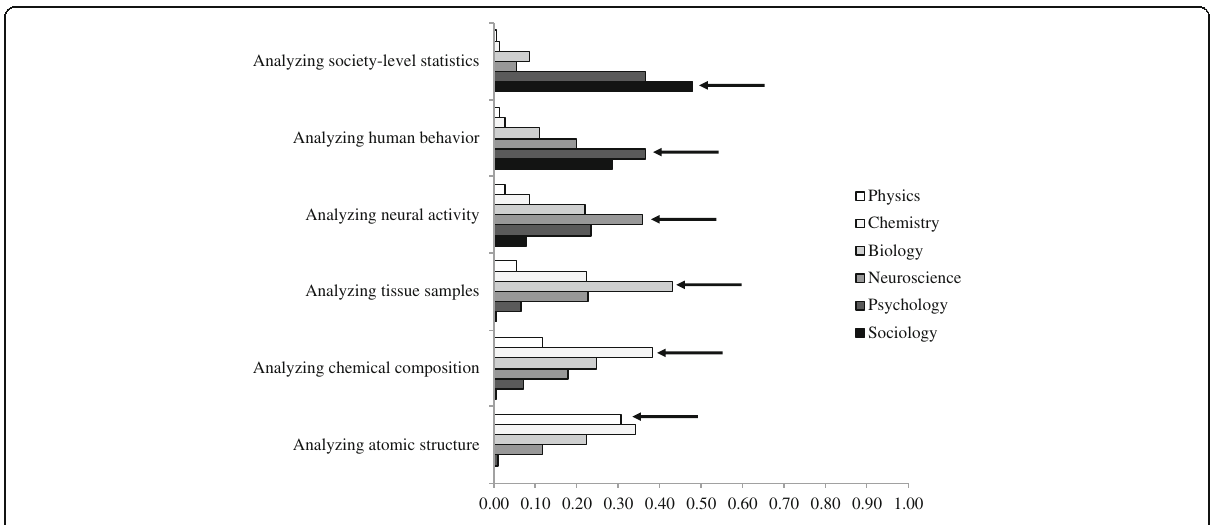
Fig. 5 Responses when asked to match methods to fields. Arrows indicate the intended field for each method